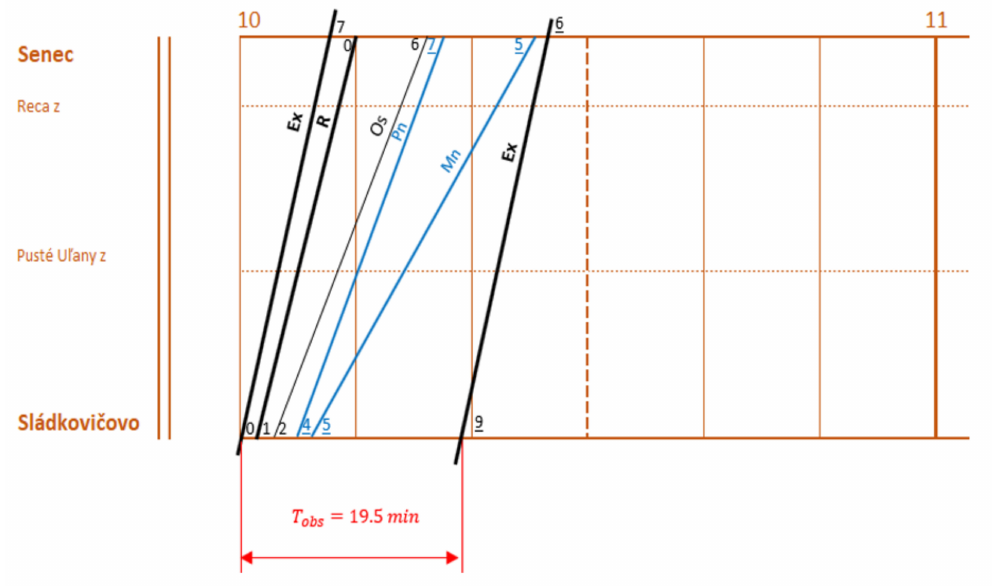
Figure 11. Occupancy time in the interstation section (ETCS L3) for a timetable